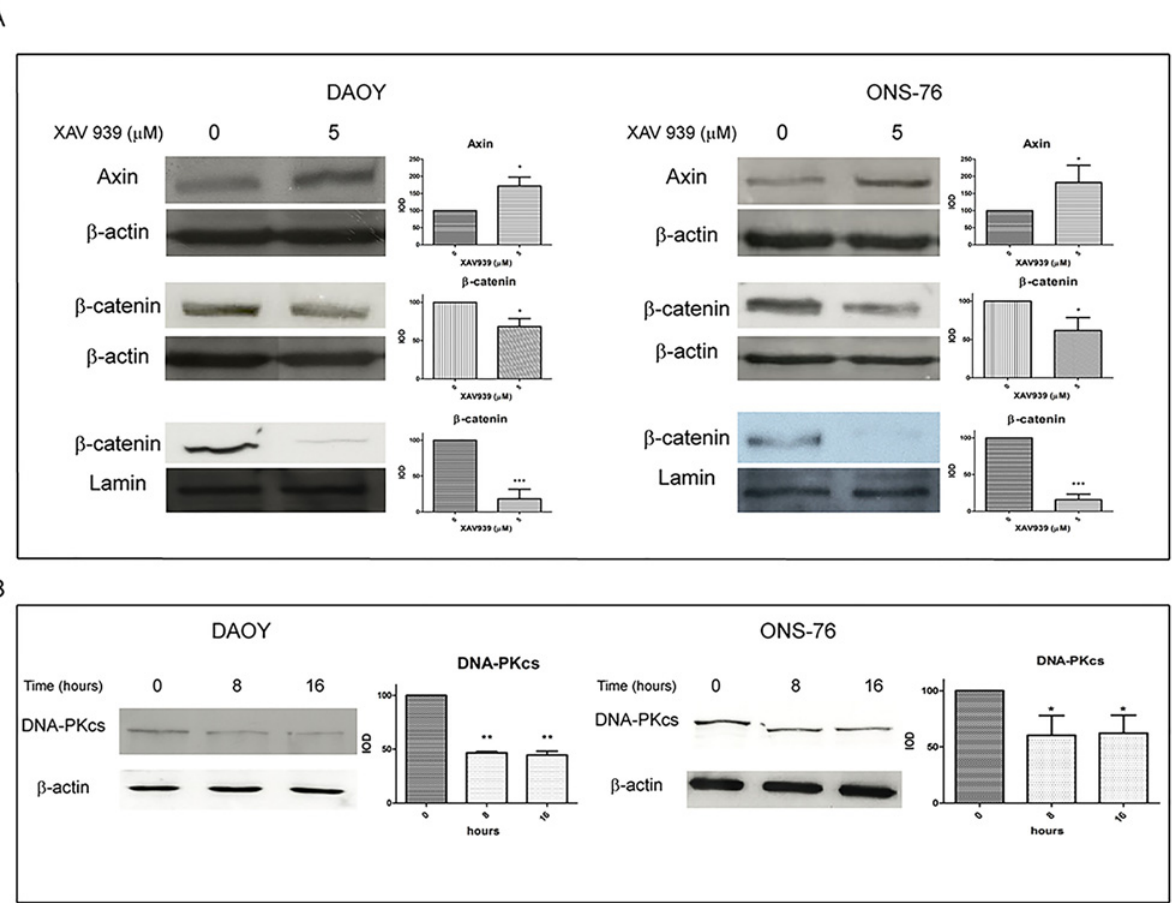
Fig 1. XAV939 inhibits TNKS PARP-activity in MB cell lines. WB analysis and densitometry of total and nuclear MB cells extracts after XAV939 treatment: MB cell lines (DAOY, ONS-76) were treated with 5 μ M XAV939 or with an equal volume of DMSO. A. Both cell lines showed an increase in total Axin protein levels at 8 h after treatment (80% and 70% respectively in ONS-76 and DAOY compared to DMSO treated control, p < . 05), followed by a β -catenin decrease in total (30%, p < . 05) and, in particular, in nuclear extracts, at 16 h after drug administration (80% reduction compared with control, p < . 001). B. XAV939 induced a DNA-PKcs protein level reduction of about 40% at 8 h and 16 h after treatment compared to non-treated control cells ( p < . 05 in A, p < . 01 in B). Densitometry data (mean ± s.e.) were normalized with β -actin (for total extracts) and lamin-b (for nuclear extracts) and are representative of the results derived from three independent